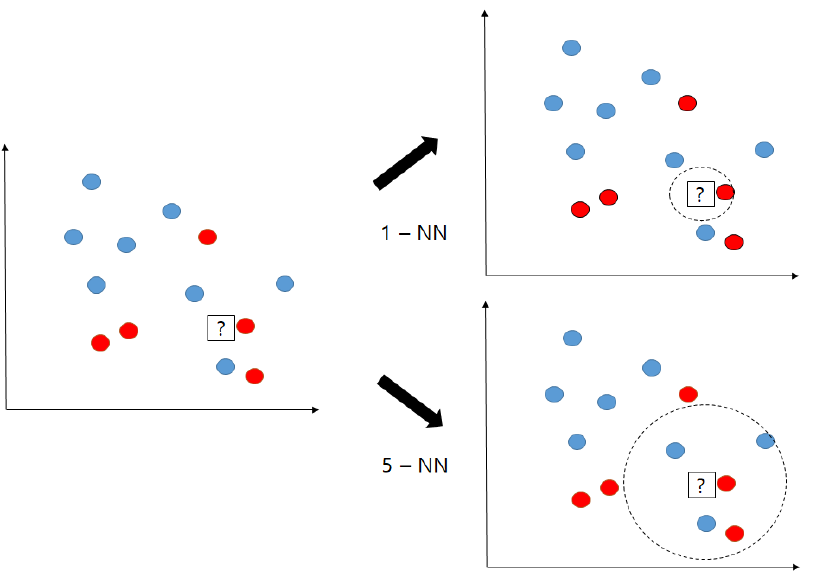
Figure A1. Example of K-NN: 1-NN and 5-NN cases.